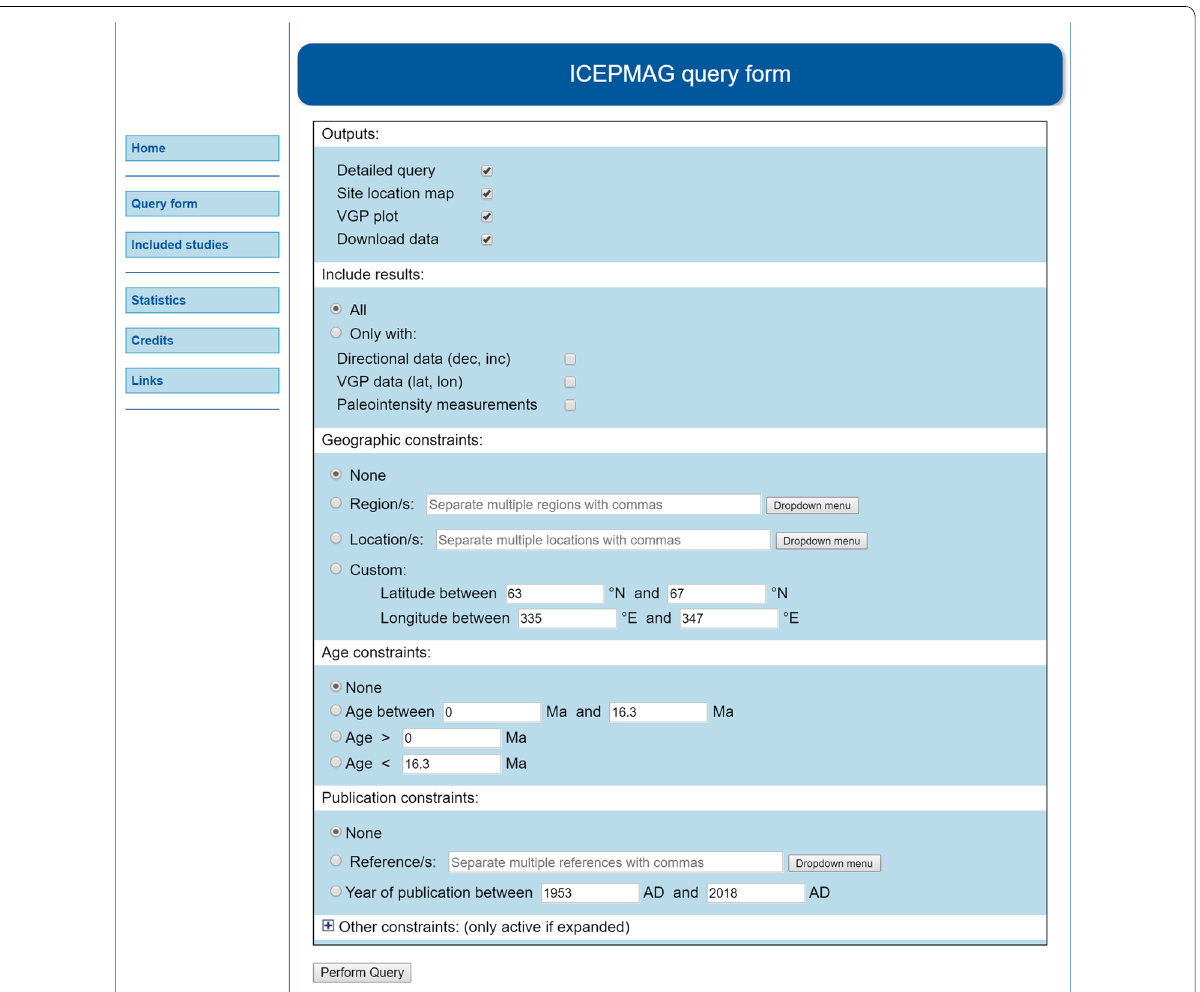
Fig. 2 ICEPMAG query form. Screenshot of the query form for ICEPMAG’s website. Additional search options can be viewed by expanding the ‘Other constraints’